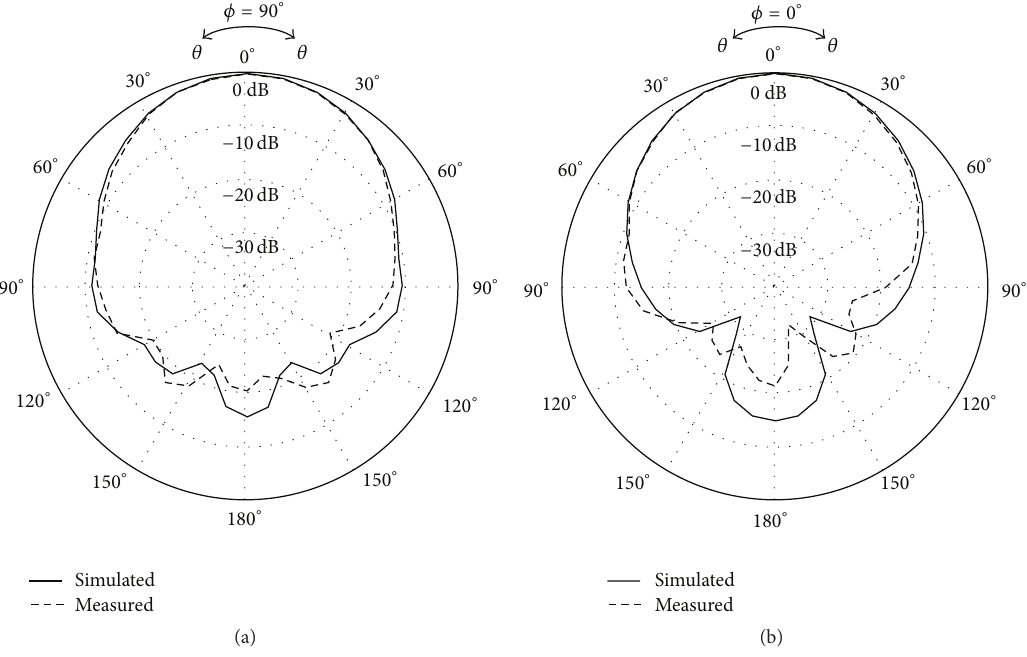
Figure 23: The simulated and measured radiation patterns at 2.45 GHz: (a) 𝐸 -plane and (b) 𝐻